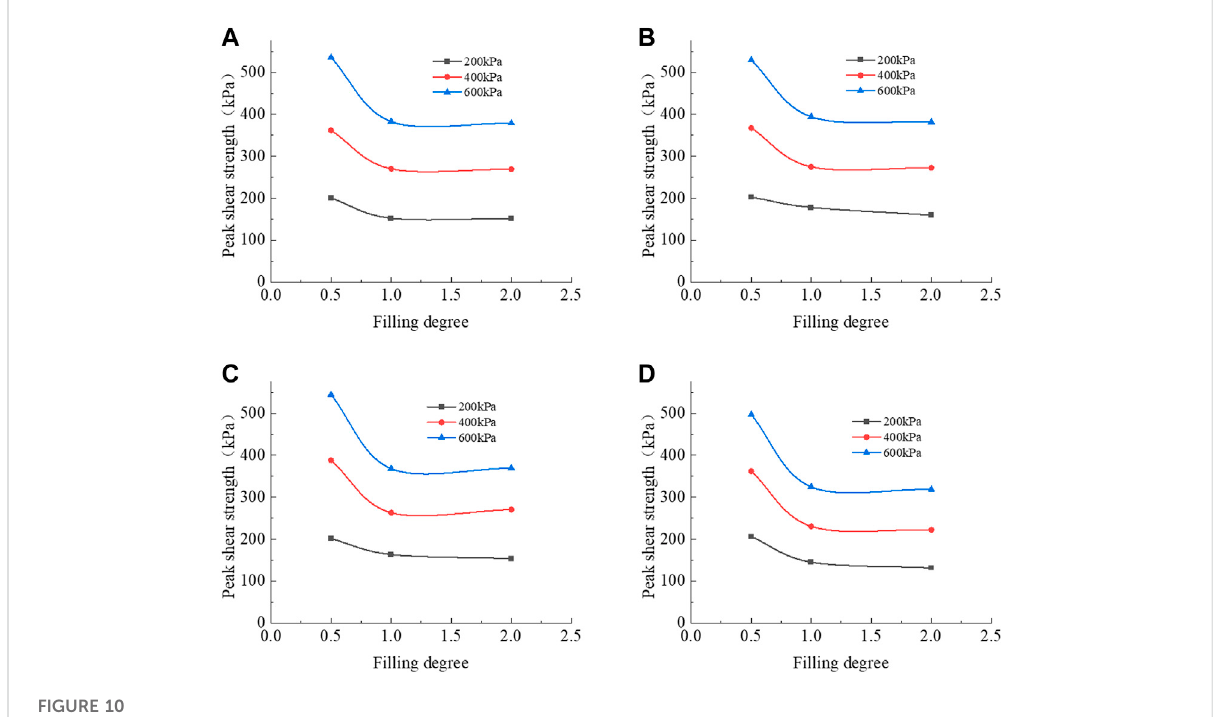
FIGURE 10 Peak Shear Strength under different fi lling degrees: (A) W = 10%; (B) W = 15%; (C) W = 20%; (D) W = 25%.